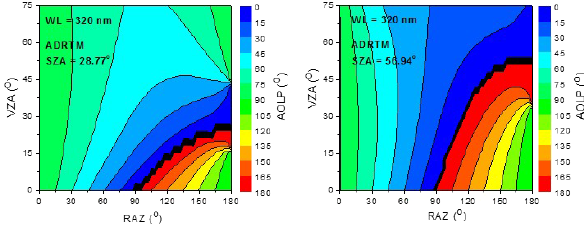
Figure 22. The modeled AOLP of desert-reflected solar light at the wavelength of 320nm. The SZA is 28.77 and 56.94 ◦ , respectively, in the modeling.